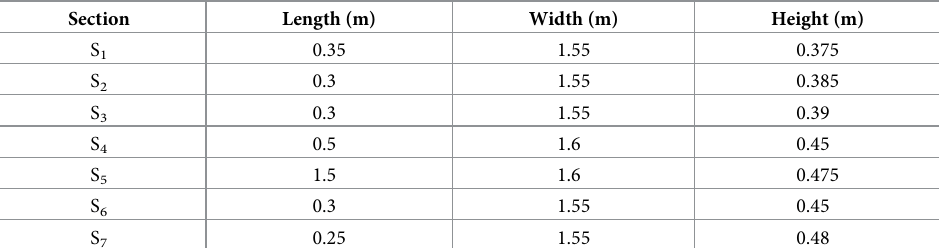
Table 4. Vehicle modeling—Citroe¨n AX.